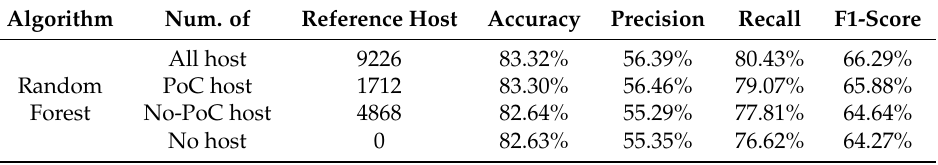
Table A2. Test set 2 results of the exploit prediction experiment based on Reference